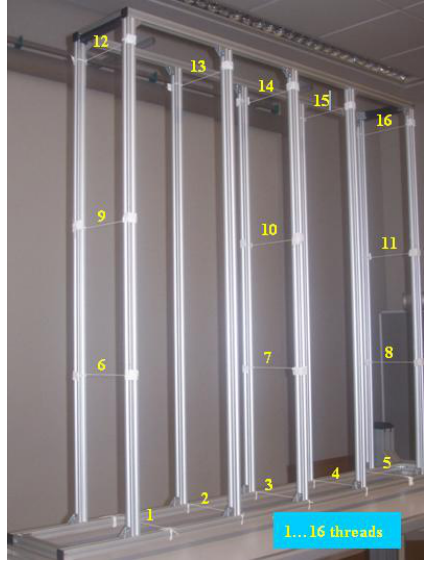
Figure 4. Calibration pattern comprising